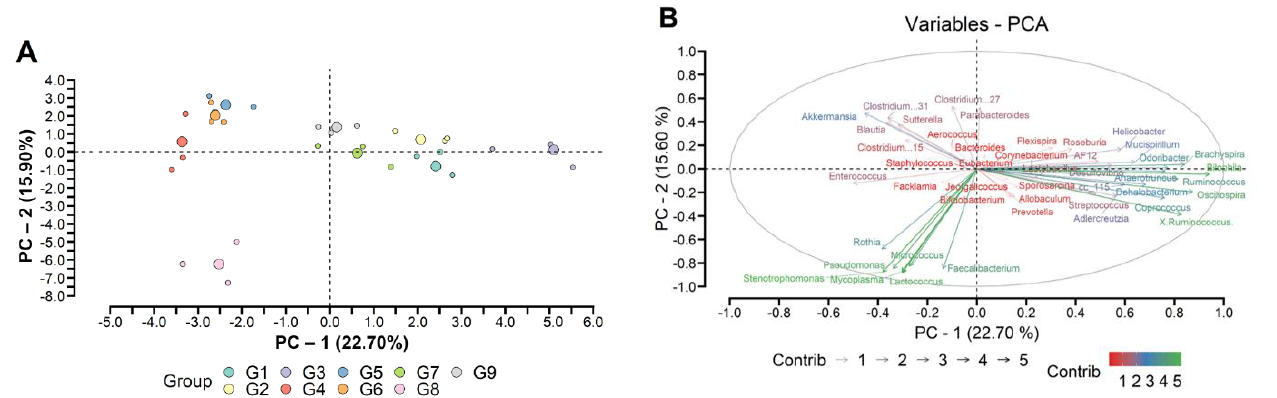
Figure 2. Principal Component Analysis (PCA) ( A ) and factorial analysis ( B ) are based on the most abundant OTUs (relative abundance >0.1%) at the genus level across the groups. G1: negative control group, G2: high fat diet (HFD), G3: LG-G12 HFD, G4: cefriatoxane HFD, G5: cefriatoxane + LG-G12 HFD, G6: standard fat diet (SFD), G7: LG-G12 SFD, G8: cefriatoxane SFD, G9: cefriatoxane + LG-G12 SFD. The red-to-green gradient indicates a low to high magnitude of the contribution of a given genus for a specific factor.